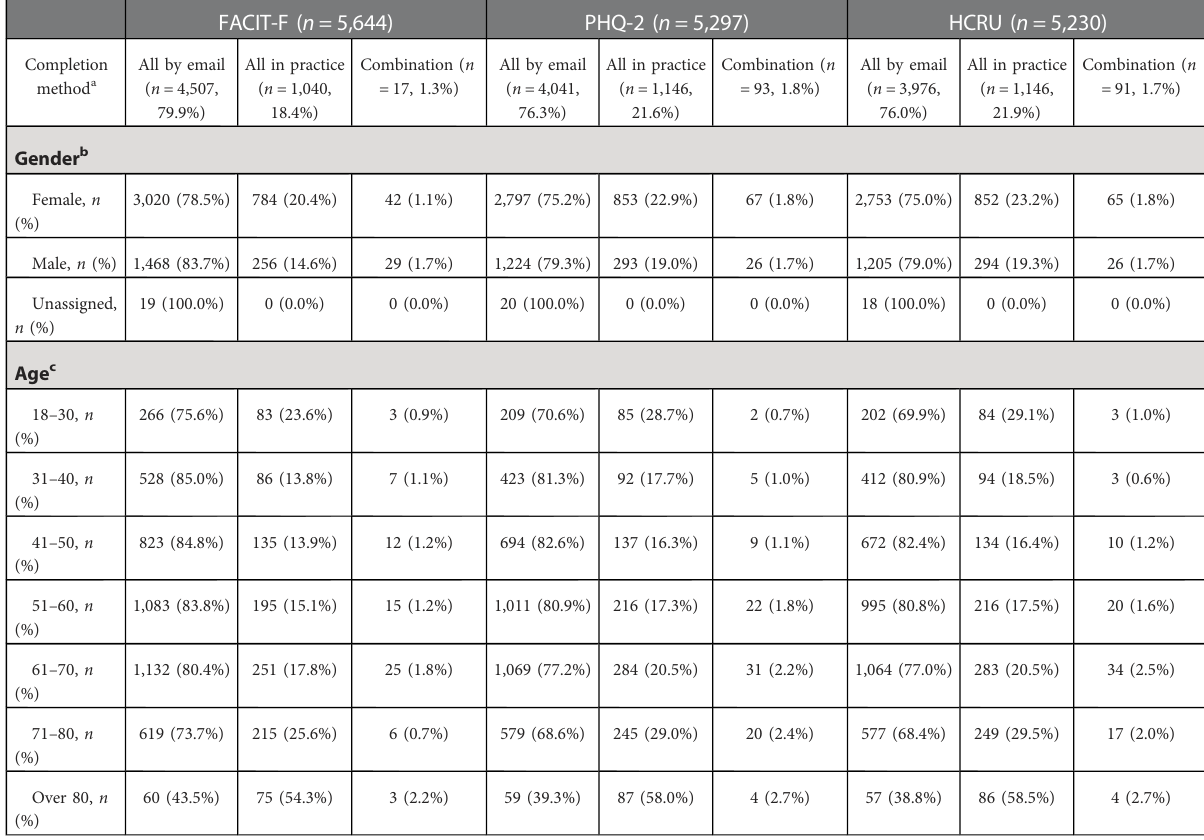
TABLE 4 Longitudinal completion method for patients in each PRO